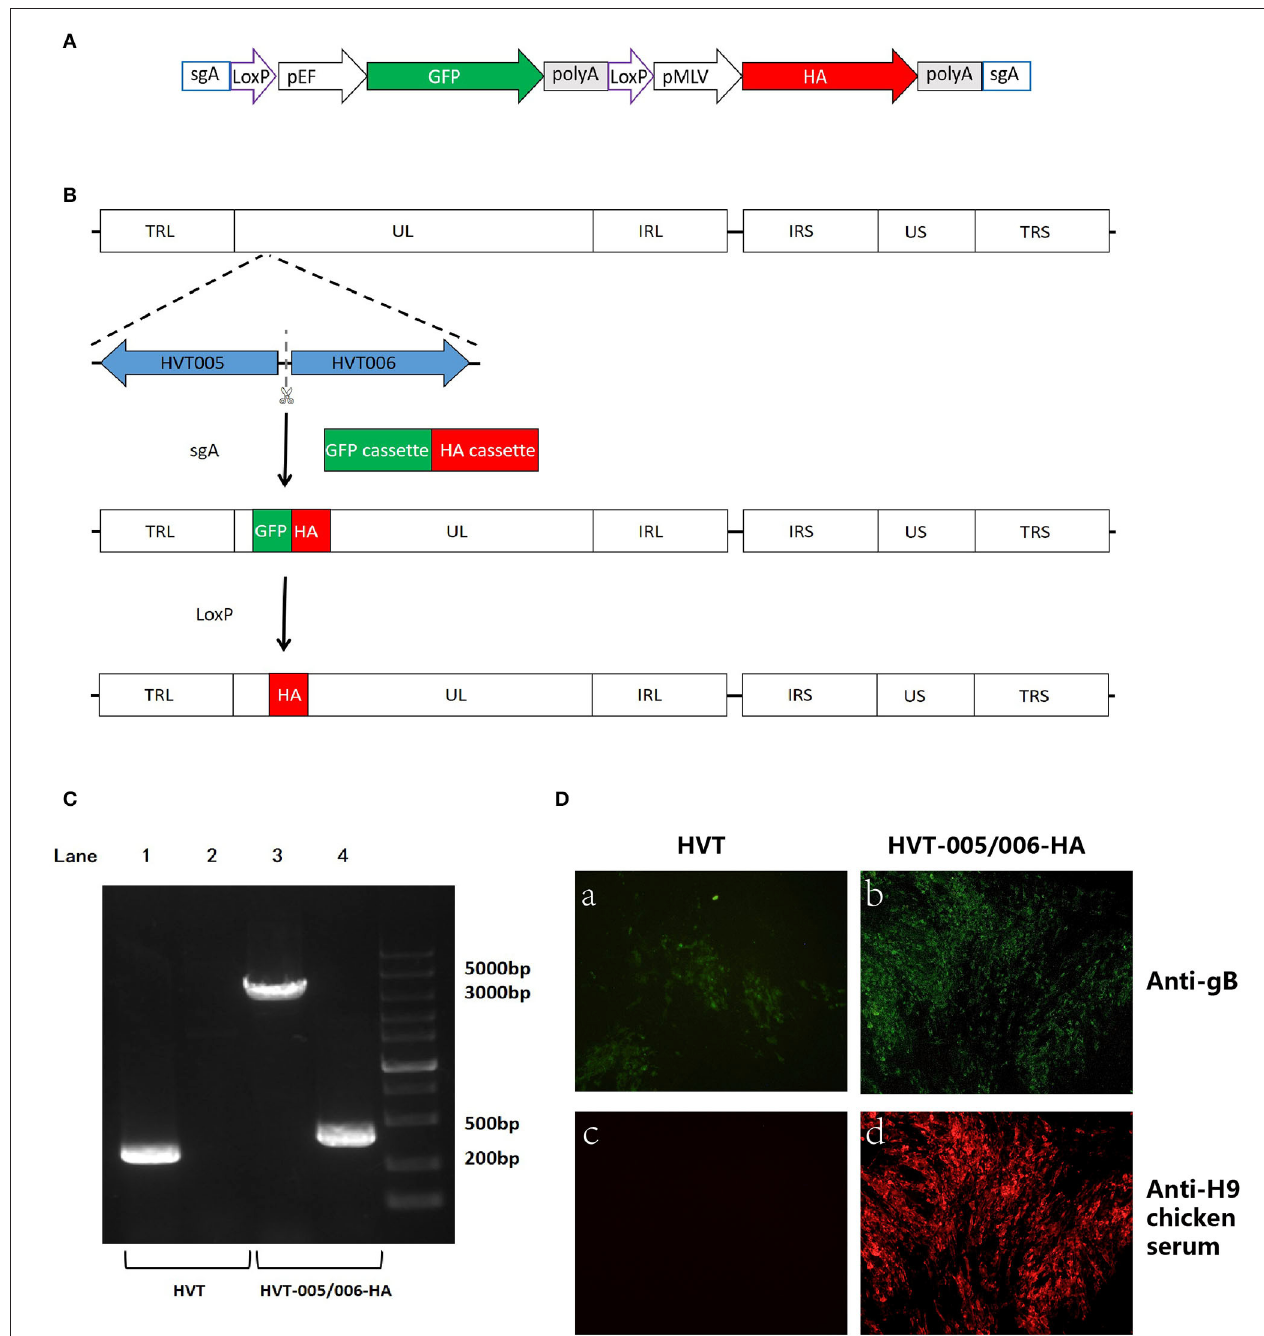
FIGURE 2 | Construction and characterization of recombinant HVT-005/006-HA. (A) Schematic representation of the donor construct. The elements include Cas9 target site sgA, LoxP sequences, GFP cassette, and HA cassette. The sgA site was used for releasing the insertion fragment of the GFP cassette along with the HA cassette. The LoxP sequences were used for the excision of the GFP cassette. (B) Schematics of the strategy for insertion of HA cassette in the HVT-005/006 site. Both GFP and HA cassettes were inserted in the HVT-005/006 site to obtain the HVT-005/006-HA-GFP. HVT-005/006-HA was obtained after the removal of the GFP cassette by Cre recombinase. (C) PCR analysis of the inserted HA gene cassette using primer pairs outside the insertion HVT-005/006 site or amplifying part of the HA gene. Lane 1 PCR for the inserted HA cassette amplified from HVT DNA with the primer pair T-005/006-F and T-005/006-R, Lane 2 PCR for the part of HA sequence amplified from HVT DNA with the primer pair of T-HA-F and T-HA-R, Lane 3 PCR for the inserted HA cassette amplified from HVT-005/006-HA DNA with the primer pair T-005/006-F and T-005/006-R, and Lane 4 PCR for the part of HA sequence amplified from HVT-005/006-HA DNA with the primer pair of T-HA-F and T-HA-R. (D) Detection of HA expression with IFA using anti-H9 chicken serum. HVT infection was confirmed by immunostaining with anti-gB monoclonal antibody BD8. IFA for CEFs infected with HVT using anti-gB monoclonal antibody BD8 (a) . IFA for CEFs infected with HVT-005/006-HA using anti-gB monoclonal antibody BD8 (b) . IFA for CEFs infected with HVT using anti-H9 chicken serum (c) . IFA for CEFs infected with HVT-005/006-HA using anti-H9 chicken serum (d)